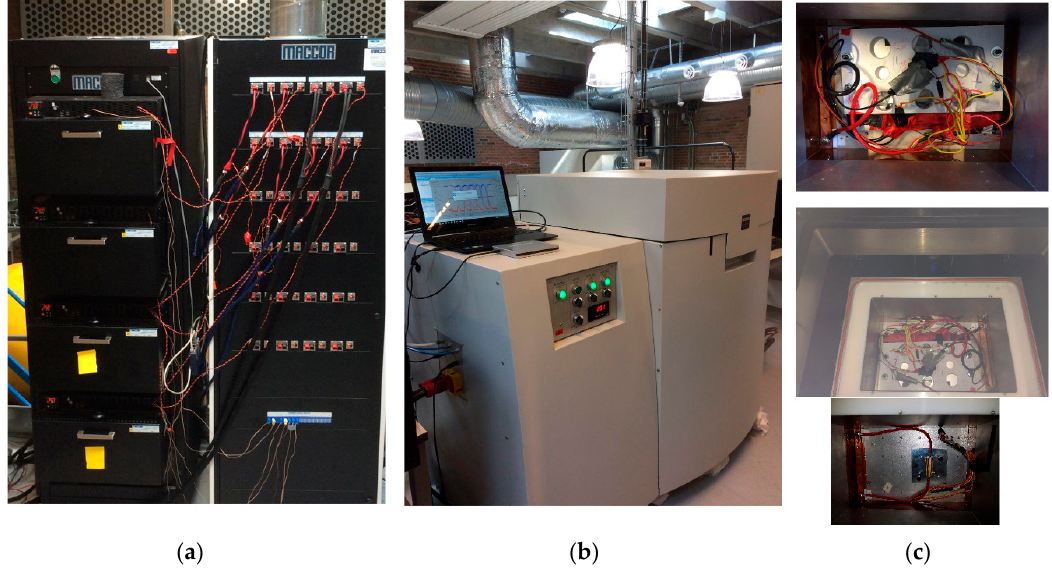
Figure 3. Experimental facilities. ( a ) Maccor automated test system; ( b ) Isothermal battery calorimeter; ( c ) Battery and resistance inside the calorimeter.